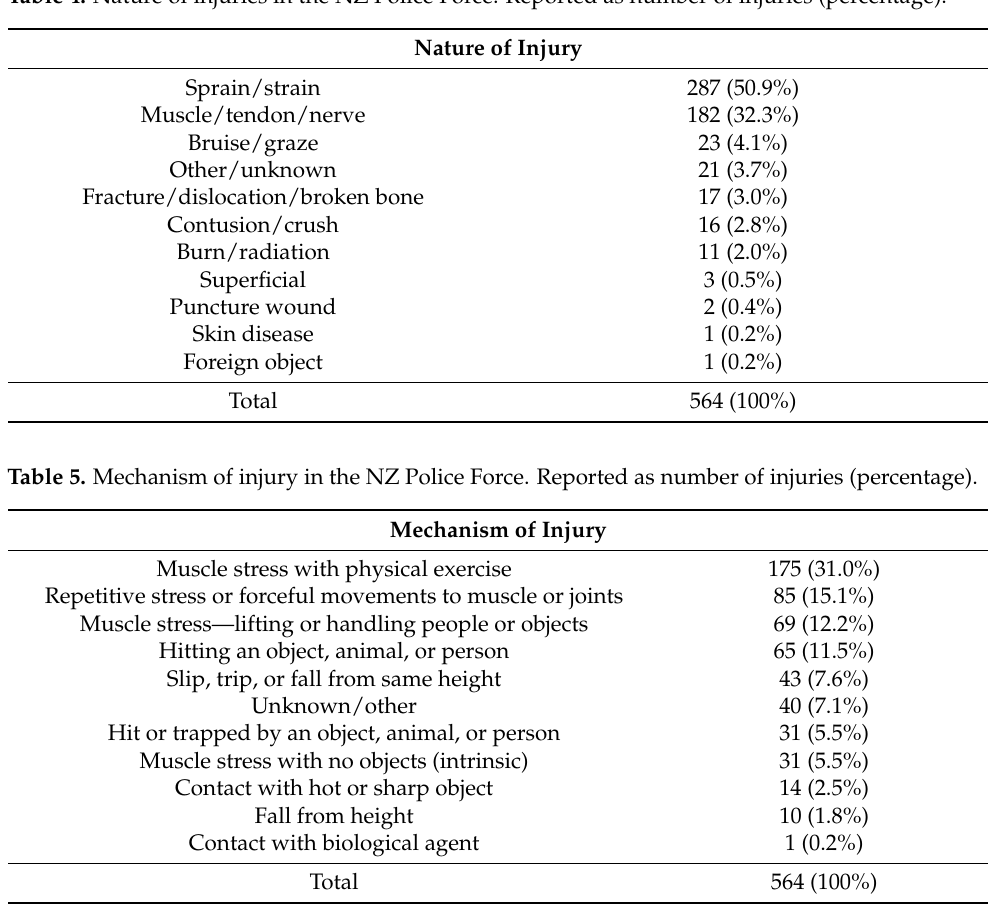
Table 4. Nature of injuries in the NZ Police Force. Reported as number of injuries (percentage).